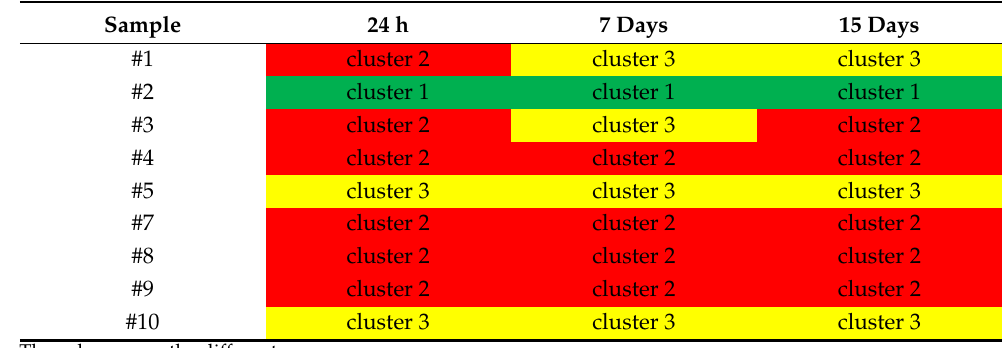
Figure 4. Cluster analysis related to the different samples ( a ) test at 24 h; ( b ) test at 7 days; ( c ) test at 15 days). Samples: #1—Pope with red dress; #2—Pope with white dress; #3—gladiator with black crest; #4—gladiator with red crest; #5—gladiator with laurel crown; #7—centurion; #8—footballer; #9—gladiator with gladius (i.e., a Roman sword); #10—Pope with red cross and zucchetto. Table 5. Representation of the cluster analysis during the three leaching tests. The different colors represent the three clusters. For sample identification, see Figure 4.